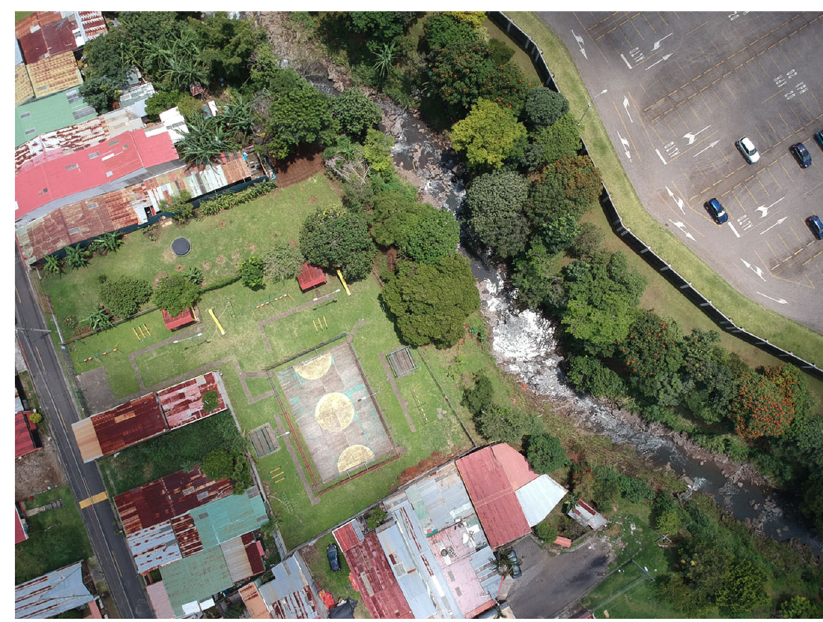
Fig. 2 Ecological connectivity and socio-economic accessibility is improved by nature-based solutions in the Cantón Flores, Heredia Province, Costa Rica. Drone image from the Quebrada Seca River next to the real world lab of the SEE-URBAN-WATER project. Source: Dennis